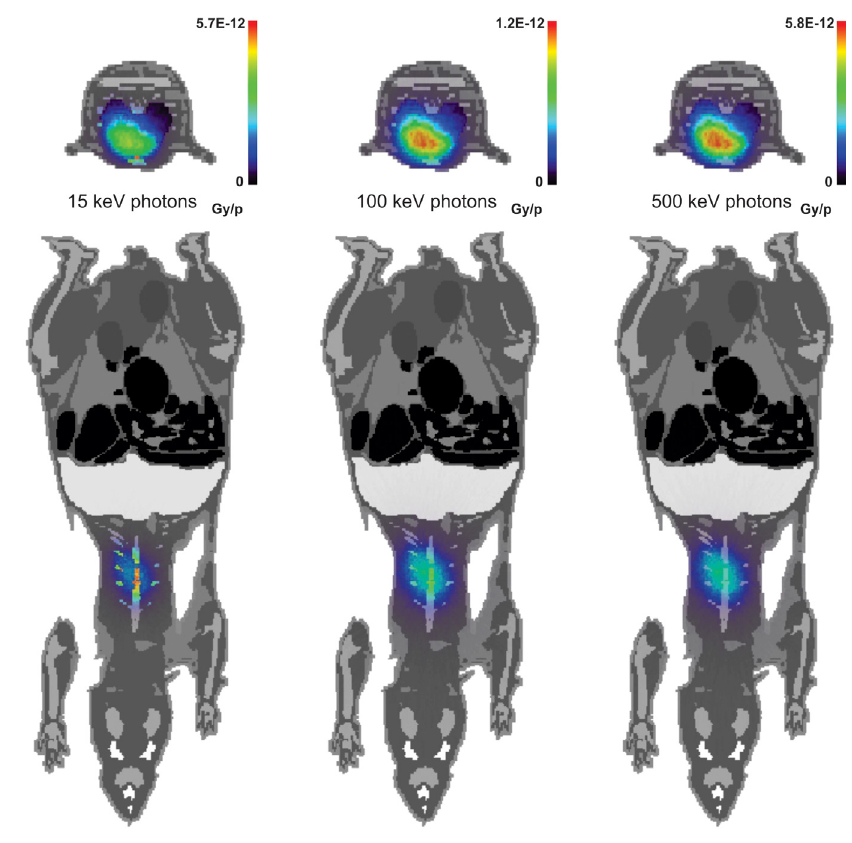
FIGURE 4 - Transversal and coronal slices of absorbed doses distribution pattern fused with model representation image. The maximum absorbed doses per emitted particle were spotted on ribs inner surfaces for a 15 keV photons at heart source. For 100 keV to 500 keV photons the maximum absorbed dose was observed in the